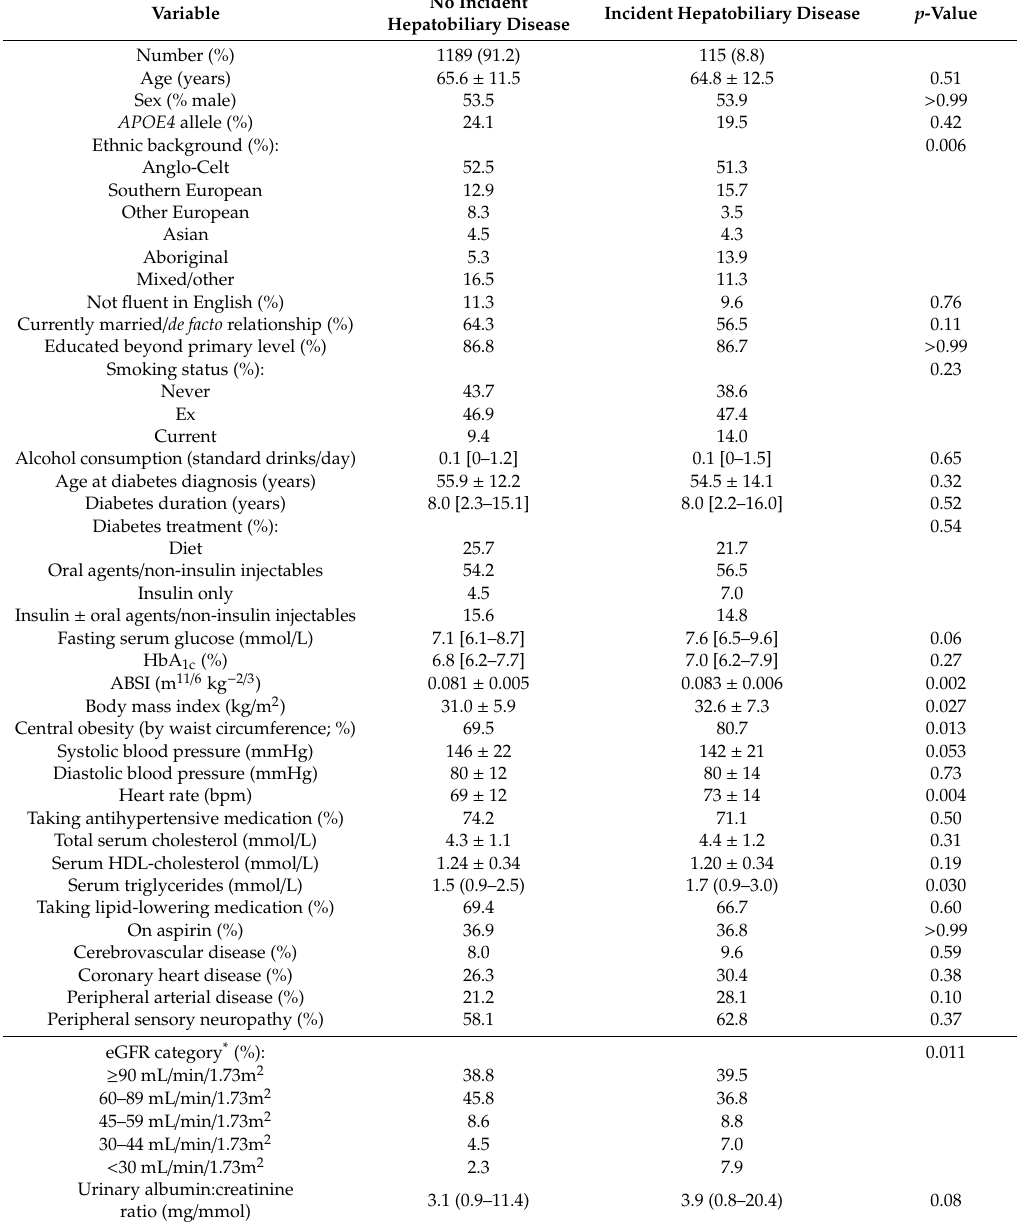
Table 4. Baseline characteristics of type 2 diabetes participants in the Fremantle Diabetes Study Phase II who had no prior history of hepatobiliary disease by incident hepatobiliary disease status. Data